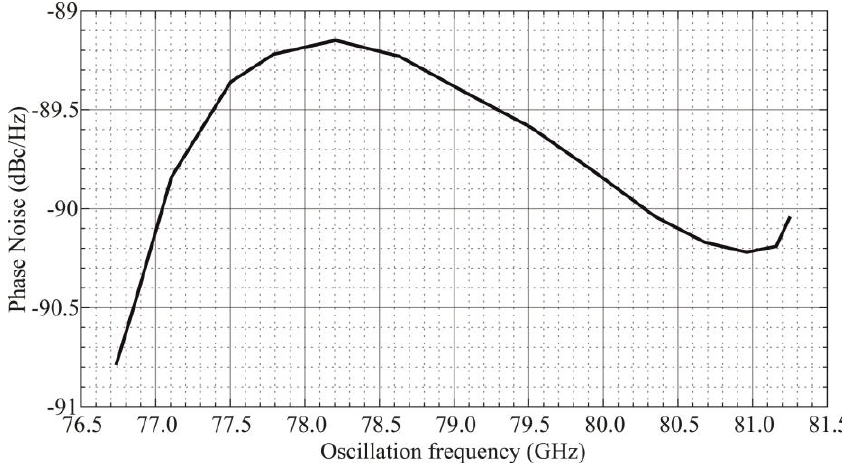
Fig. 5. Simulated phase noise versus oscillation frequency at 1 MHz